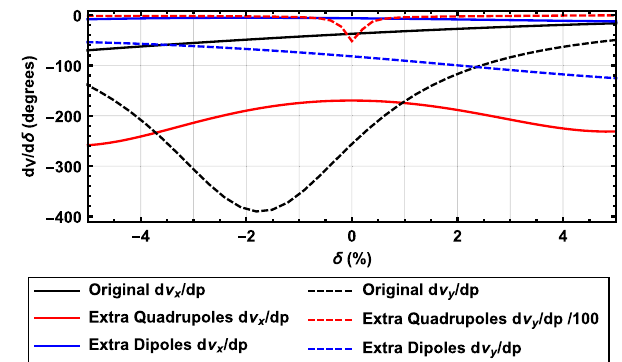
FIG. 11. Derivative of the phase advance with respect to δ at the end of BC1 for the original lattice (black), extra quadrupoles (red) and extra dipole solutions